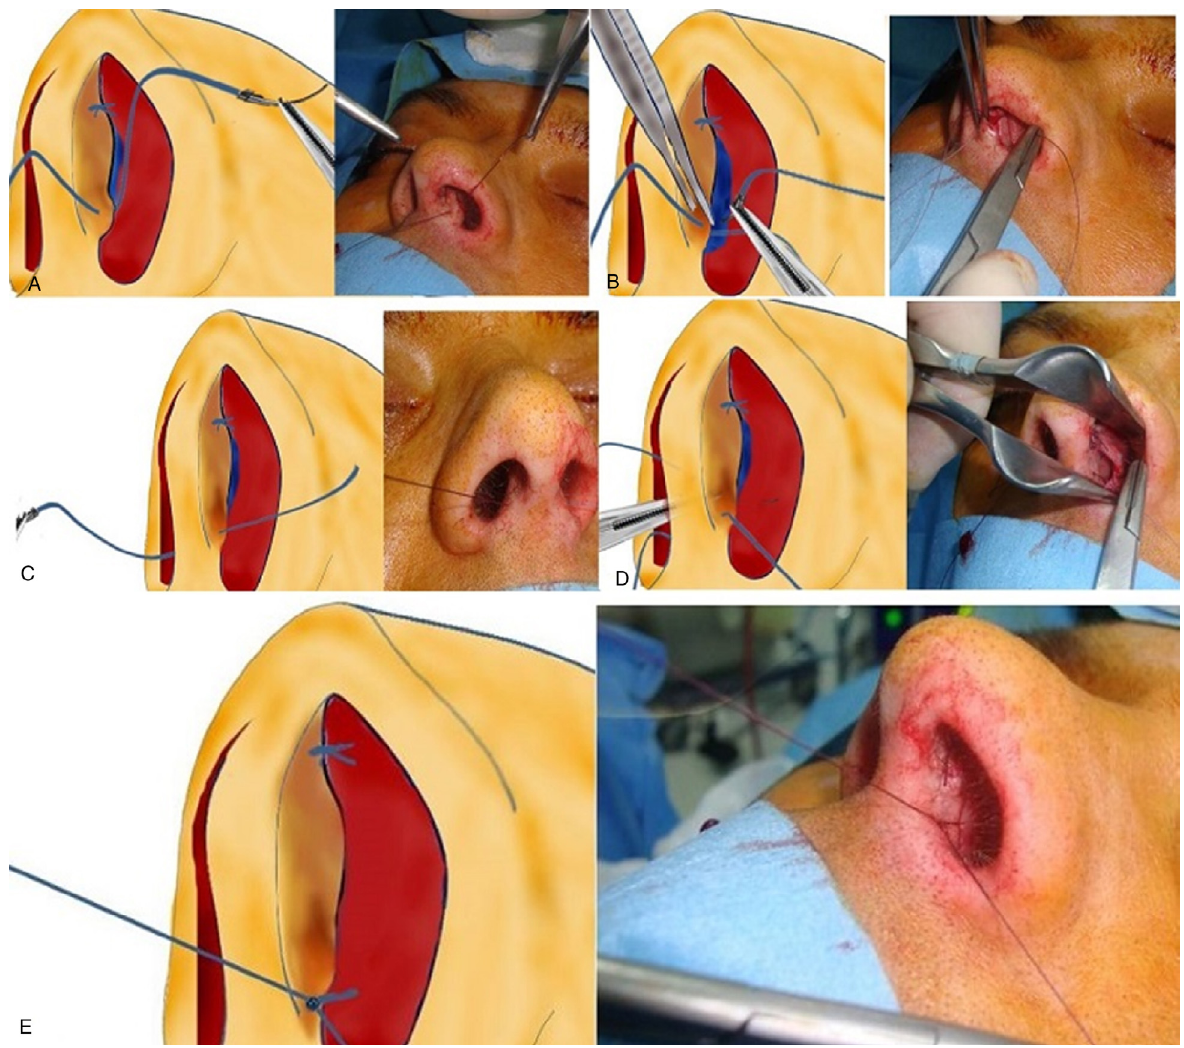
Figure 2 The sequences of the inferior septocolumellar